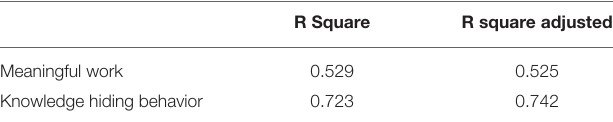
TABLE 5 | Predictive accuracy and relevance of the model.